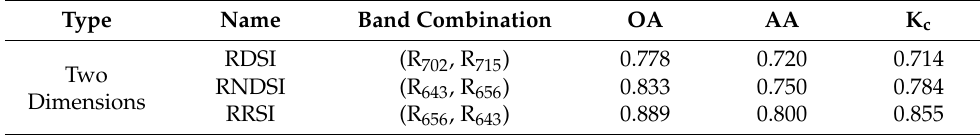
Table 3. The grade performance of the sensitive RISIs and band